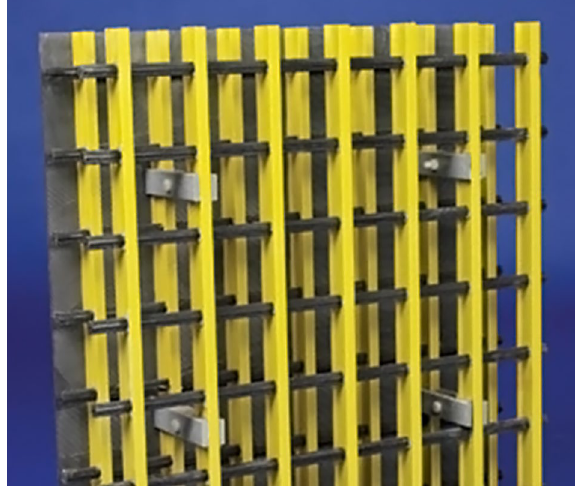
Fig. 4. Fiberglass grid form for bridge decks (photo from http://www.gefinc.com)